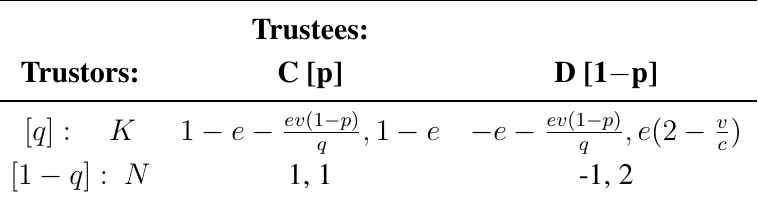
Table 2. Payoffs Under the Moral